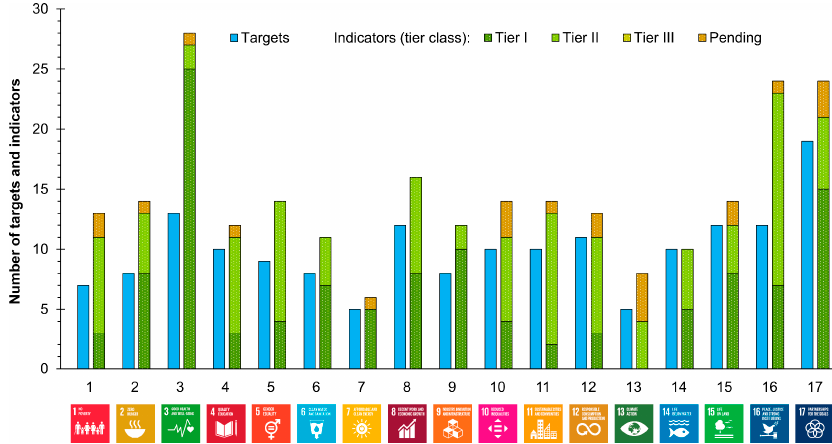
Figure 1. Distribution of targets and indicators across the 17 SDGs. These data were sourced from the March 2020 version of the global indicator framework for the SDGs [3] and the April 2020 version of the tier classification for global SDG indicators [20]. The global indicator framework was adopted by the UN General Assembly in July 2017 and is contained in the resolution designated A/RES/71/313 [4,21]. As of this writing, the latest version of the list of SDG indicators bears the following notations in the upper right corner of the downloadable PDF document: A/RES/71/313, E/CN.3/2018/2, E/CN.3/2019/2, and E/CN.3/2020/2 [3]. These notations mean that the current official list of indicators [3] includes the global indicator framework as contained in A/RES/71/313, the refinements agreed by the UN Statistical Commission at its 49th session in March 2018 (E/CN.3/2018/2, Annex II) and 50th session in March 2019 (E/CN.3/2019/2, Annex II), and the changes from the 2020 Comprehensive Review (E/CN.3/2020/2, Annex II) and annual refinements (E/CN.3/2020/2, Annex III) from the 51st session in March 2020 [21].